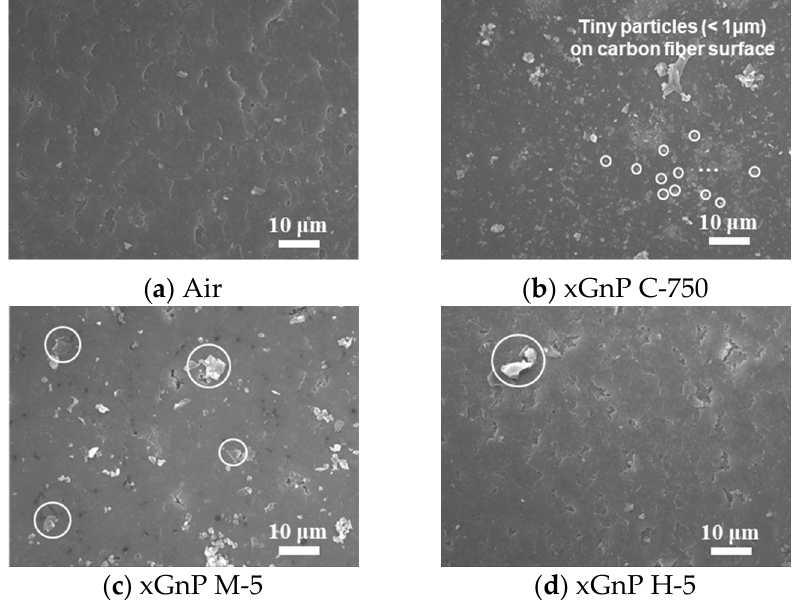
( d ) xGnP H-5 Figure 14. 3D profiles of the 90th drilled hole and the nine sectors ([a]–[i]) For more detailed analysis, FE-SEM images of the 90th hole are shown in Figures 15 and 16. To investigate the carbon fiber cutting angles of 0° and 90°, images were taken at sectors [e] and [h], respectively, which are shown in Figure 13a. As shown in Figure 15, in the air case, small debris like carbonous materials was not